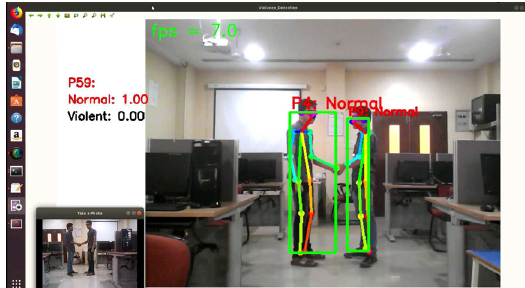
Fig. 6. Action: Non-violent